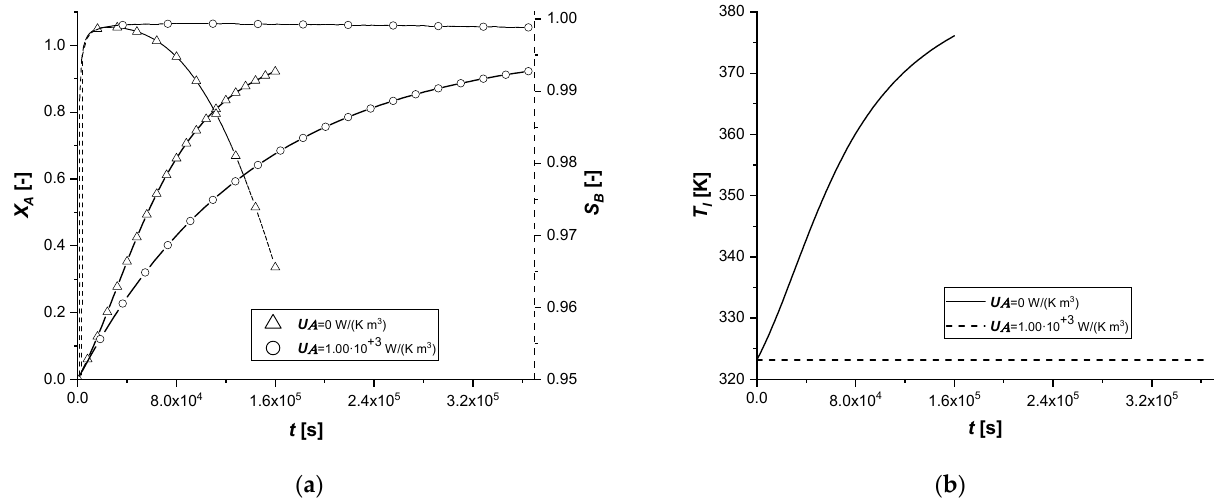
Figure 34. EY UA investigation. ( a ) Bulk profiles over time of X A and S B . ( b ) Bulk profile of T l over time. The results confirm that the presence of an energy dissipative term causes a slow- down of all chemical processes, as a consequence of the lowering of the system tempera- ture compared to the reference case. In fact, the intraparticle concentration c As profiles show a considerable accumulation of the reagent given the low reaction rates, which are functions of operation temperature. Finally, it is interesting to notice that when the desired conversion is achieved, the bulk concentration of the final product C is extremely low in all the cases. 4. Conclusions In this work, the influence of several parameters on three different catalytic systems was investigated in order to obtain a high selectivity of the intermediate product of a con- secutive reaction system A → B → C in an adiabatic batch reactor. These systems are distin- guished from each other by the different distribution of the active phase inside the catalyst particle. In the mathematical model, active phase distribution equations and appropriate mass and energy balances were implemented. Simulations of concentration profiles of all the components in the solid and liquid phases, the temperature profiles, the reactant con- version, and the product selectivity for each case were obtained. The comparison between the different catalysts, varying the most influential parameters, revealed that the catalysts with active phase distribution egg white and egg yolk always show selectivity, to the de- sired intermediate product, which is lower or, in a few case studies, comparable to that of the egg shell, which proves to be the catalyst that tends to maximize the selectivity of B. The implemented model can be easily adapted for a study in more complex systems, and, for continuous reactor systems, possibly focusing the attention on the catalyst whose active phase distribution allows to maximize the selectivity of the desired product. Thus, the presented modeling approach shows the opportunity to optimize a NUD heterogene- ous catalyst placed in a specific reactor unit (e.g., packed bed, continuous stirred tank, fluidized bed reactor) for a chosen chemical system, leading to higher reactant conversion, higher product selectivity with the lowest catalyst cost. Supplementary Materials: The supplementary information is given online at www.mdpi.com/arti- cle/10.3390/chemengineering5030038/s1. Author Contributions: Conceptualization, V.R. and T.S.; methodology, E.S., V.R.; software, E.S.; validation, E.S.; formal analysis, E.S., V.R., T.S., R.T.; investigation, E.S.; data curation, E.S., V.R.; writing—original draft preparation, E.S.; writing—review and editing, E.S., V.R., T.S., R.T., M.D.S.;